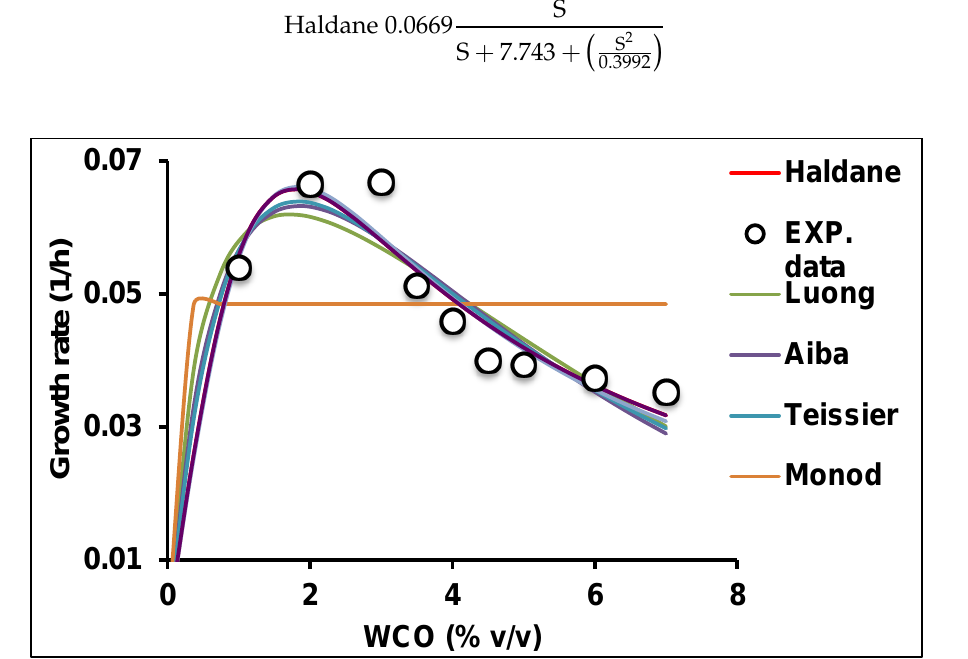
Figure 6. Modelling of bacterial growth kinetic experimental values using seven different kinetic models. Table 1. Statistical analyses of waste canola oil growth kinetics